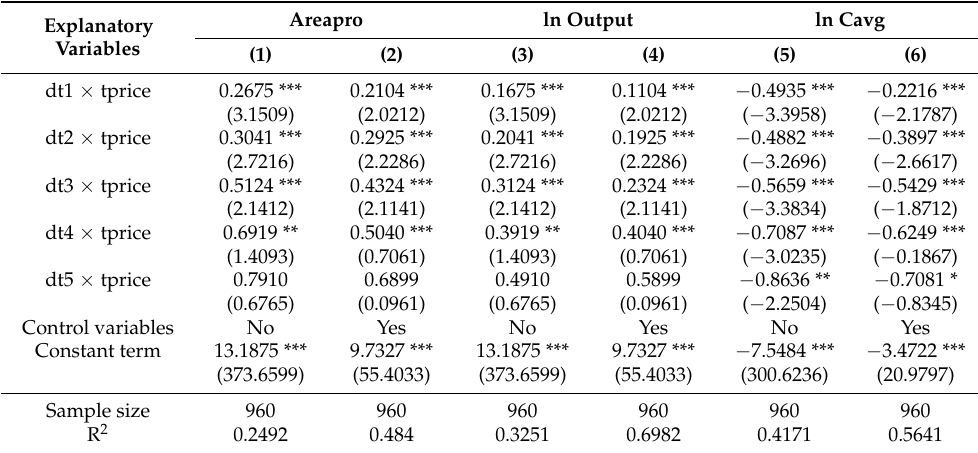
Table 4. The dynamic influence of target price policy on cotton planting.